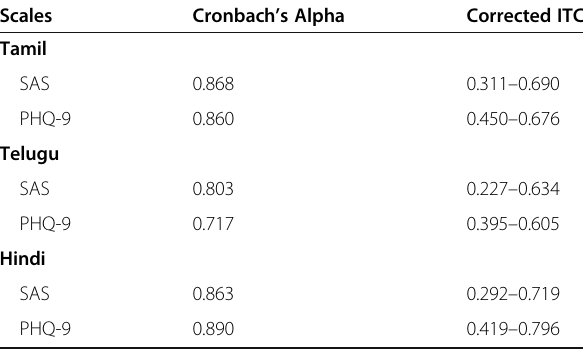
Table 4 Internal consistency reliability and ITC for SAS and PHQ-9 across Tamil, Telugu, Hindi Scales